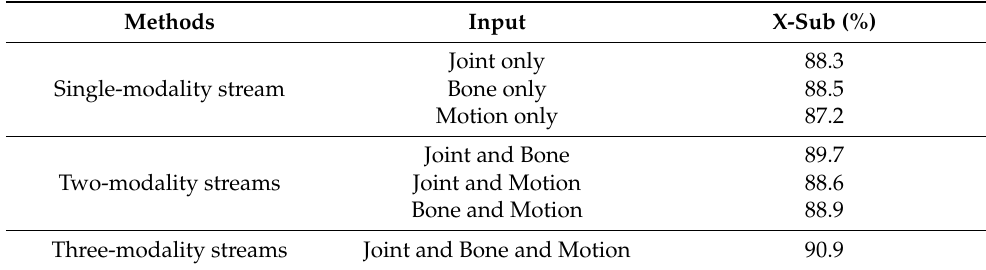
Table 4. Comparisons of the recognition accuracy with a different input stream on the NTU RGB+D X-sub benchmark.